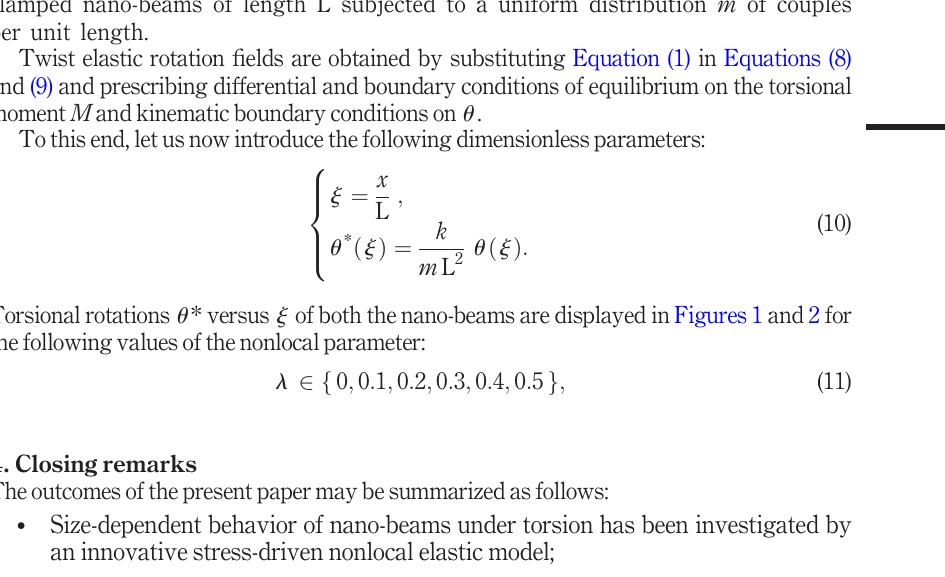
Figure 1. Nanocantilever under